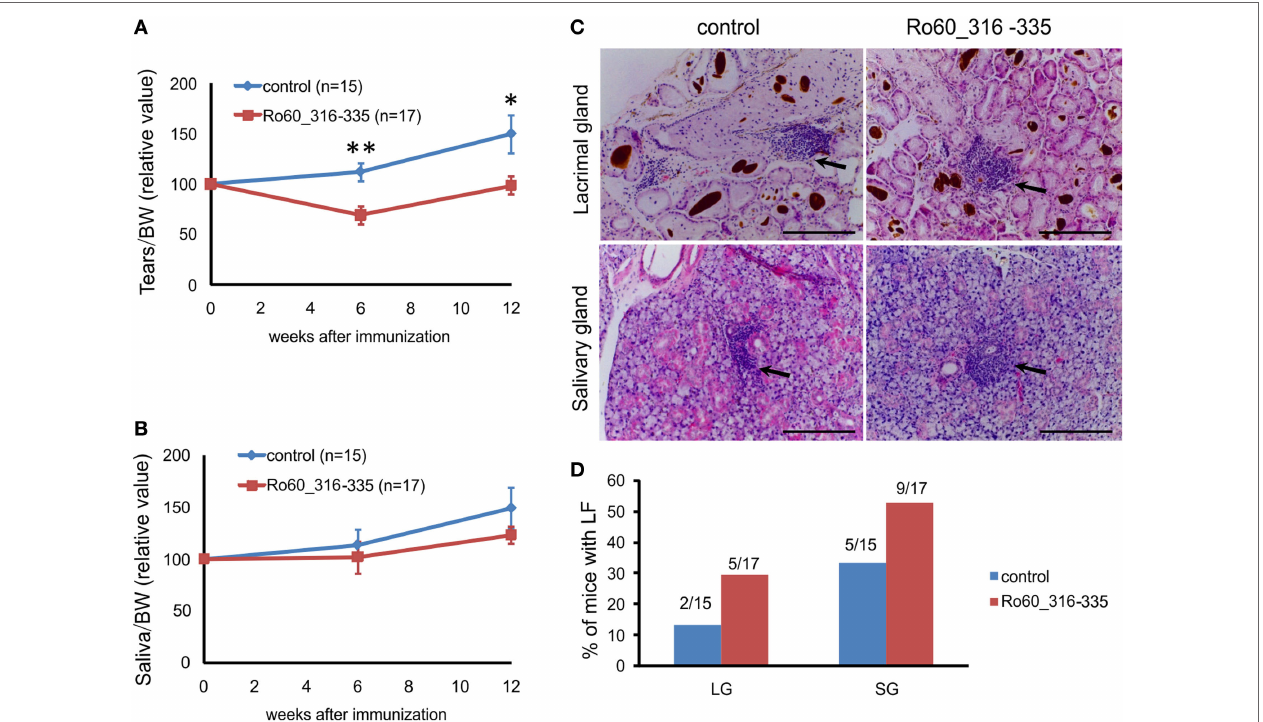
FigUre 1 | Immunization with the Ro60_316-335 peptide induces a primary Sjögren’s syndrome-like disease in C3H/He mice. C3H/HeJ mice were immunized with Ro60_315-336 ( n = 17) or treated with PBS as control ( n = 15) and secretion of tears (a) and saliva (B) was determined after pilocarpine stimulation. Values were normalized to the respective body weights and subsequently to the levels of secretion determined before immunization. Results two experiments were pooled and data are presented as mean ± SEM. Statistically significant differences between peptide-immunized mice and controls were calculated by using the Mann–Whitney U -test (* p < 0.05 and ** p < 0.01). (c) Representative sections with lymphocytic foci (LF) derived from lacrimal (upper panel) and salivary glands (lower panel) of Ro60_315-336 immunized mice or controls after Hematoxylin and Eosin staining. Black arrows indicate LF. Bars, 100 µm. (D) Incidence of mice with LF in lacrimal and salivary glands. Numbers above bars indicate the ratio of number of mice with LF/total number of mice